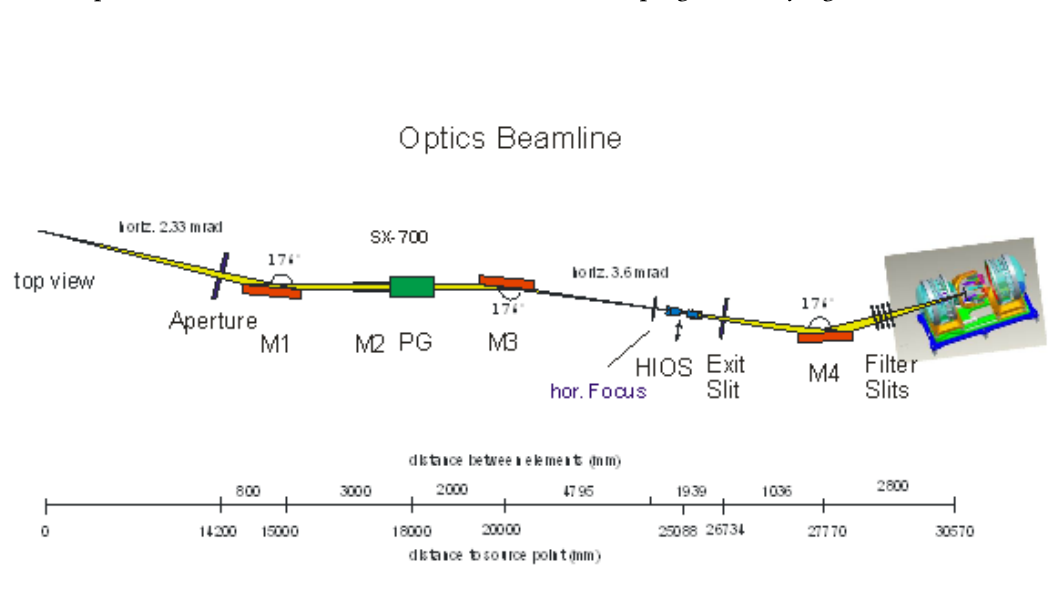
Figure 1: Optical layout of beamline PM-1 with Reflectometer end station